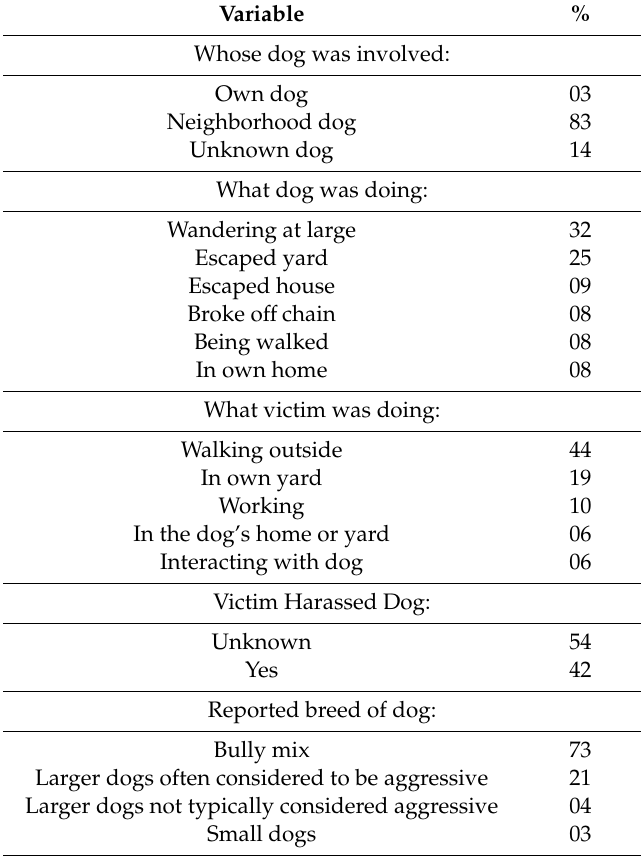
Table 1. Frequency data: most common circumstances of reported dog bites